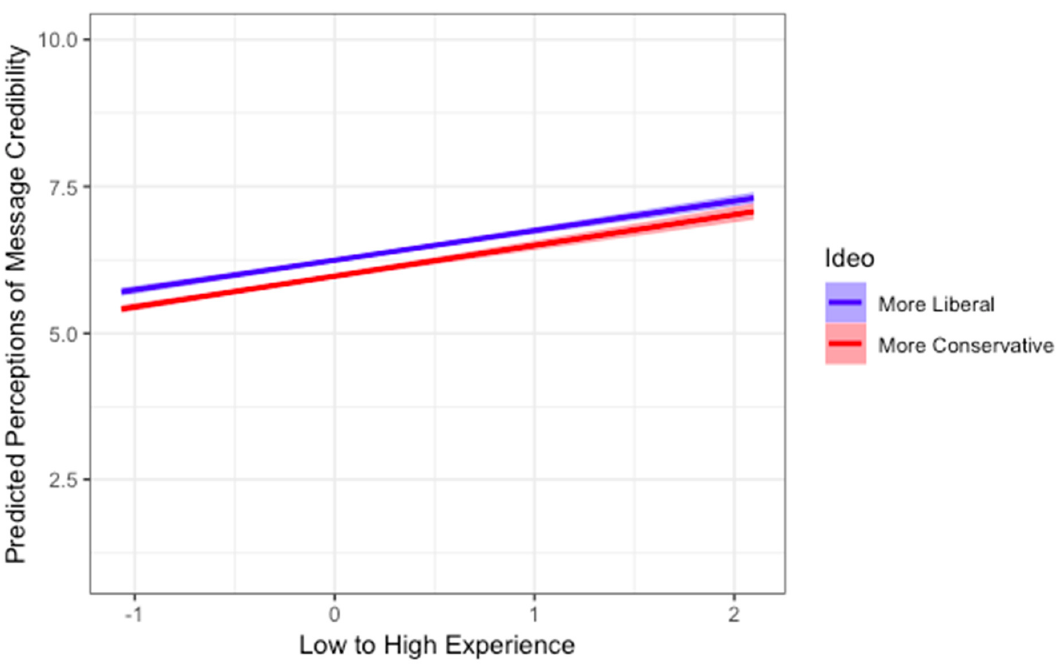
Figure 3. Higher levels of experience significantly predict perceptions of the message credibility, regardless of the political ideology. Predicted values are displayed.